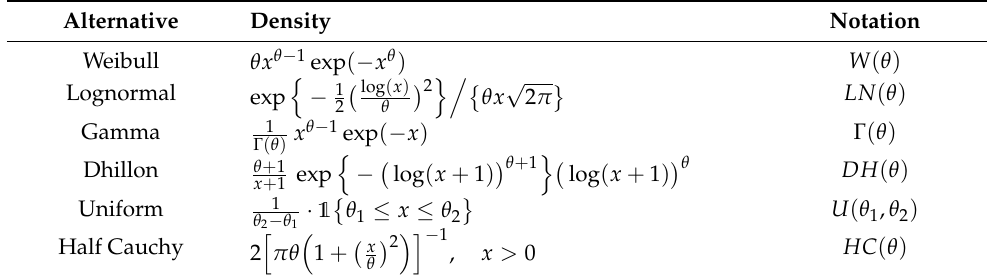
Table 1. Alternative distributions